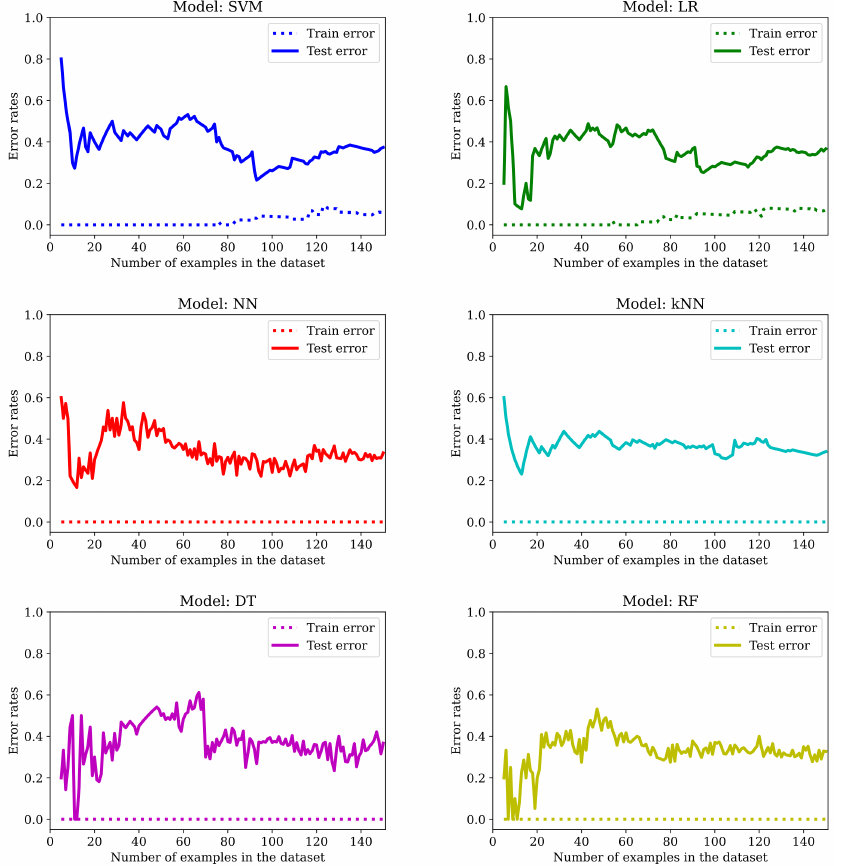
Figure 11. Evolution of errors rates with increasing number of examples in training and testing phase for the MedD